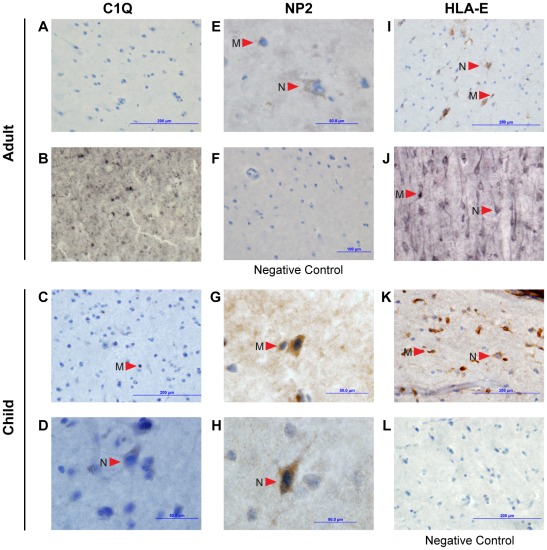
Immunohistochemistry evidence for expression of ‘immunity-related’ genes in neurons and glial cells.Immunohistochemistry showing the protein expression of C1Q, NP2 and HLA-E in nondiseased human glial cells and neurons. Arrows denote the location of microglia (M) and neurons (N). Images A–B show C1Q staining in frozen temporal lobe sections of two adults. Images C–D show C1Q staining of microglia and neurons, respectively, in frozen temporal lobe sections of a child. Image E shows NP2 staining of microglia and neurons in frozen temporal lobe sections of an adult. Image F is a negative control of the adult frozen temporal lobe tissue. Images G–H show NP2 staining of microglia and neurons, respectively, in paraffin embedded temporal lobe section of a child. Images I–J show HLA-E staining of both microglia and neurons in frozen temporal lobe sections of two adults. Image K shows HLA-E staining of microglia and neurons in a frozen temporal lobe section of a child. Image L is a negative control of the frozen temporal lobe section of the child. We found evidence for the expression of all three proteins in both cell types of the child. However, in the adult, NP2 and HLA-E were present in both cell types but there was no evidence of C1Q expression.